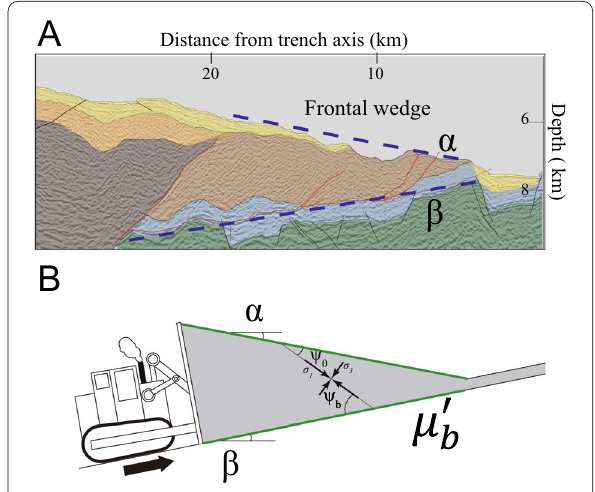
Fig. 1 Schematic illustration of the critical taper model. A Cross section of the forearc wedge in the Japan Trench ( modified from Kimura et al. 2012). α : slope angle, β : basal dip angle, μ b ′ effective friction on the megathrust fault. The frontal wedge area is between the blue broken lines. B Diagram showing the self‑similar growth of a bulldozer wedge (modified from Dahlen 1990). σ 1 : compressive principal stress, ψ 0 : the angle between σ 1 and the upper slope, ψ b : the angle between